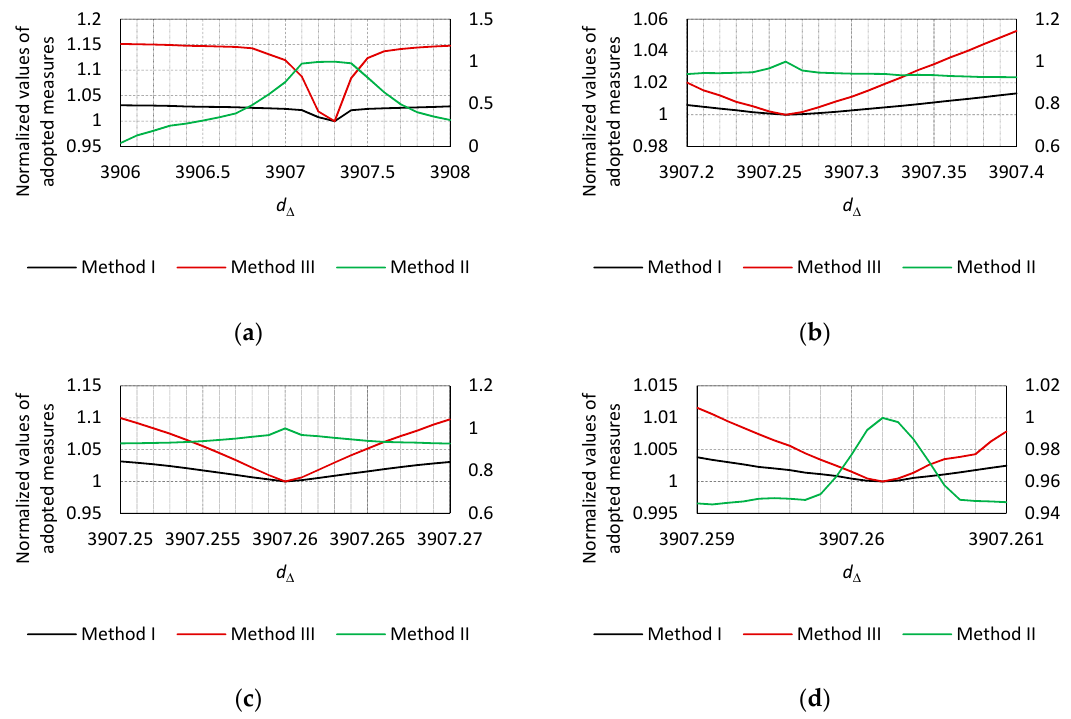
Figure 22. The normalized values of the adopted measures (method I, II and III) calculated in domain of image line length d ∆ for the accuracy ( a ) ∆ = 0.1, ( b ) ∆ = 0.01, ( c ) ∆ = 0.001 and ( d ) ∆ = 0.0001 (for the original image shown in Figure 7c).